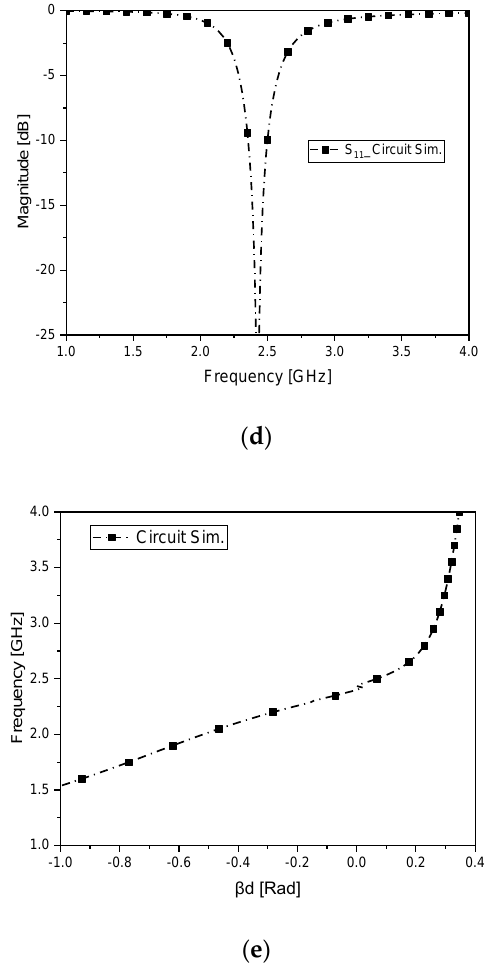
Figure 3. Equivalent circuit setup for a proper antenna. ( a ) Basic CRLH circuit; ( b ) E-CRLH circuit; ( c ) modification of the E-CRLH circuit model for antenna’s size reduction; ( d ) S 11 of the E-CRLH circuit; ( e ) dispersion diagram of the E-CRLH equivalent circuit.